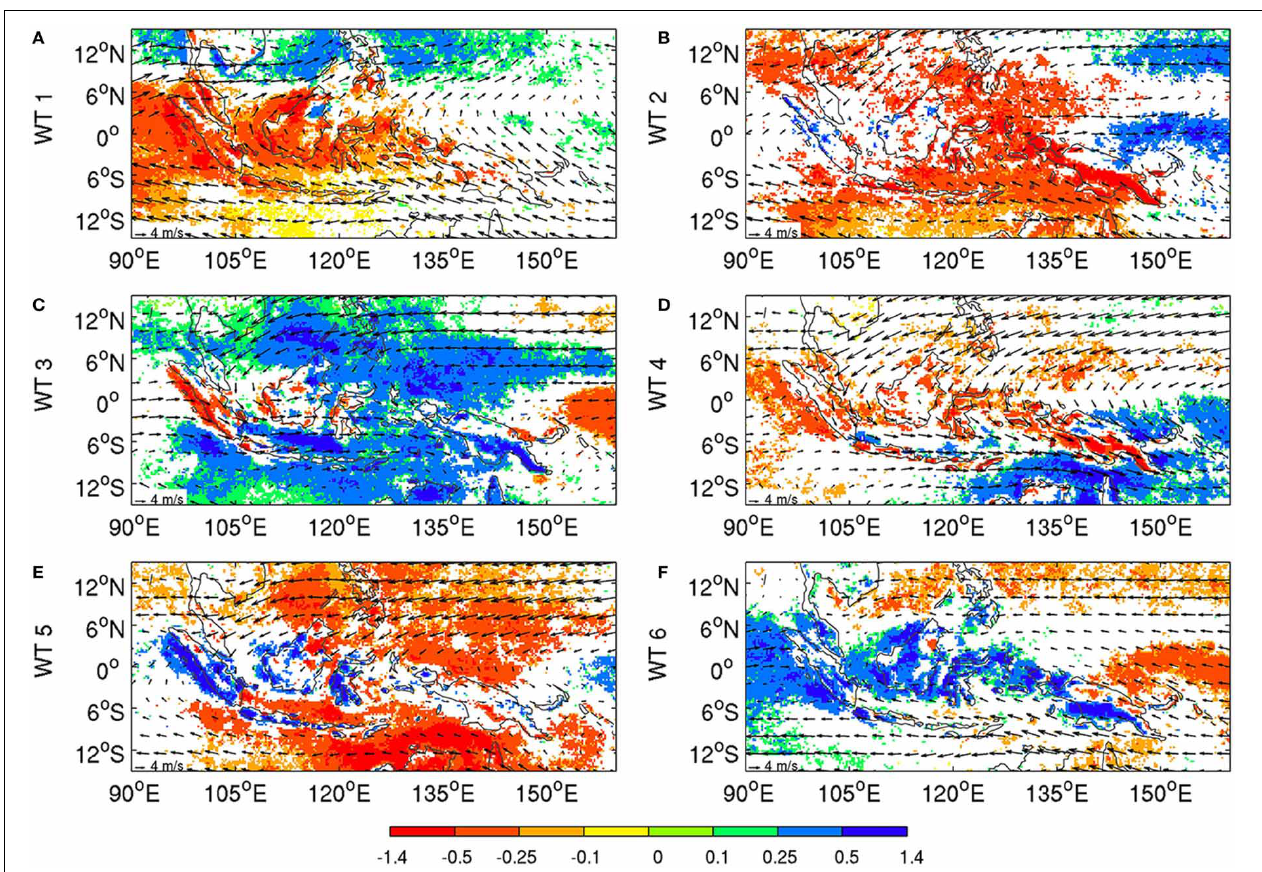
FIGURE 11 | TRMM rainfall anomalies (shadings) for the peak of the diurnal cycle at each grid point and raw 850-hPa daily winds (vectors) for (A) WT 1, (B) WT 2, (C) WT 3, (D) WT 4, (E) WT 5, (F) WT 6. The TRMM anomalies are computed as the differences from the